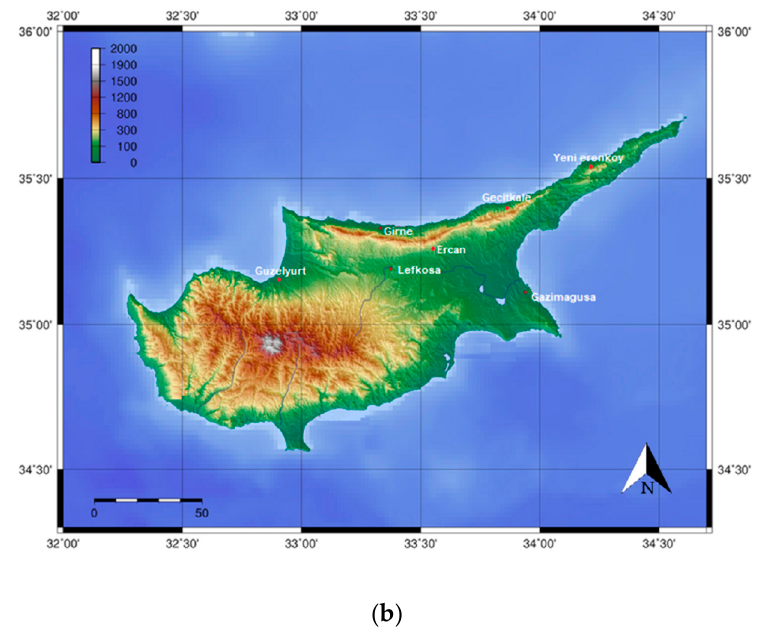
Figure 1. ( a ) Situation map of study area; ( b ) Location of stations. Atmosphere 2019 , 10 , x FOR PEER REVIEW